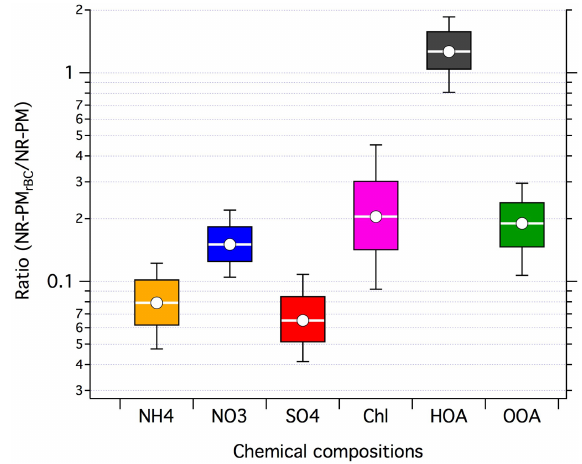
Figure 6. NR-PM rBC -to-NR-PM ratios for individual aerosol com- ponents and PMF factors (box plots: 10th, 25th, 50th, 75th, and 90th percentiles; white circles: mean values; OOA = ([OOA-1] + [OOA-2])/([NOOA] + [VOOA]) = SOA rBC /SOA NR-PM ; and HOA = ([HOA-rich] + [rBC-rich])/[HOA]). Only organic compo- nents for PMF factors measured with the SP-AMS were used in this calculation. HOA loadings less than 0.15µgm − 3 from the HR-ToF- AMS were removed for the calculation.